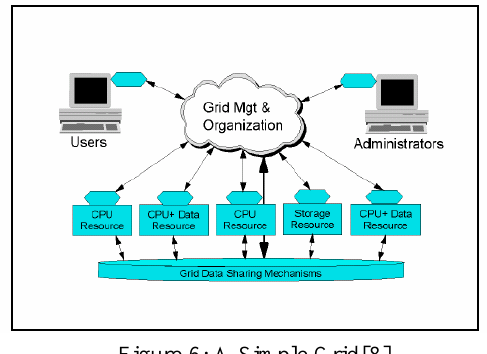
Figure 6: A Simple